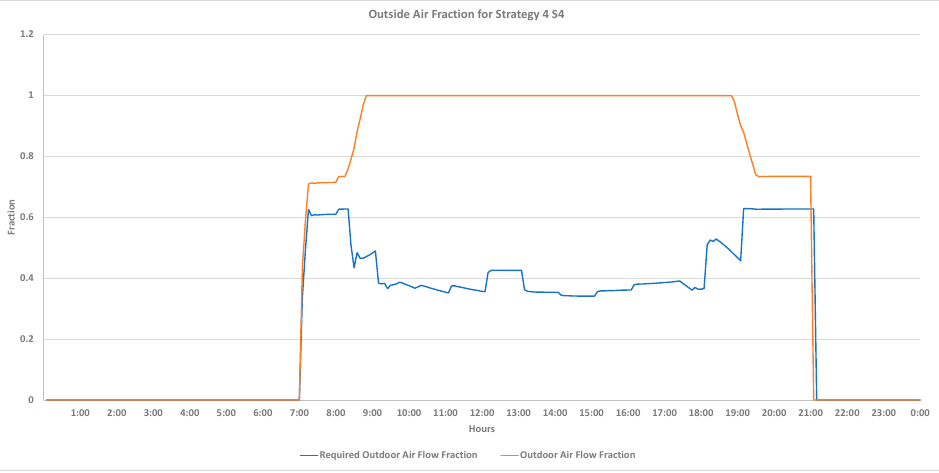
Figure 8. Required and introduced outdoor air fraction when the strategy S4 was applied.